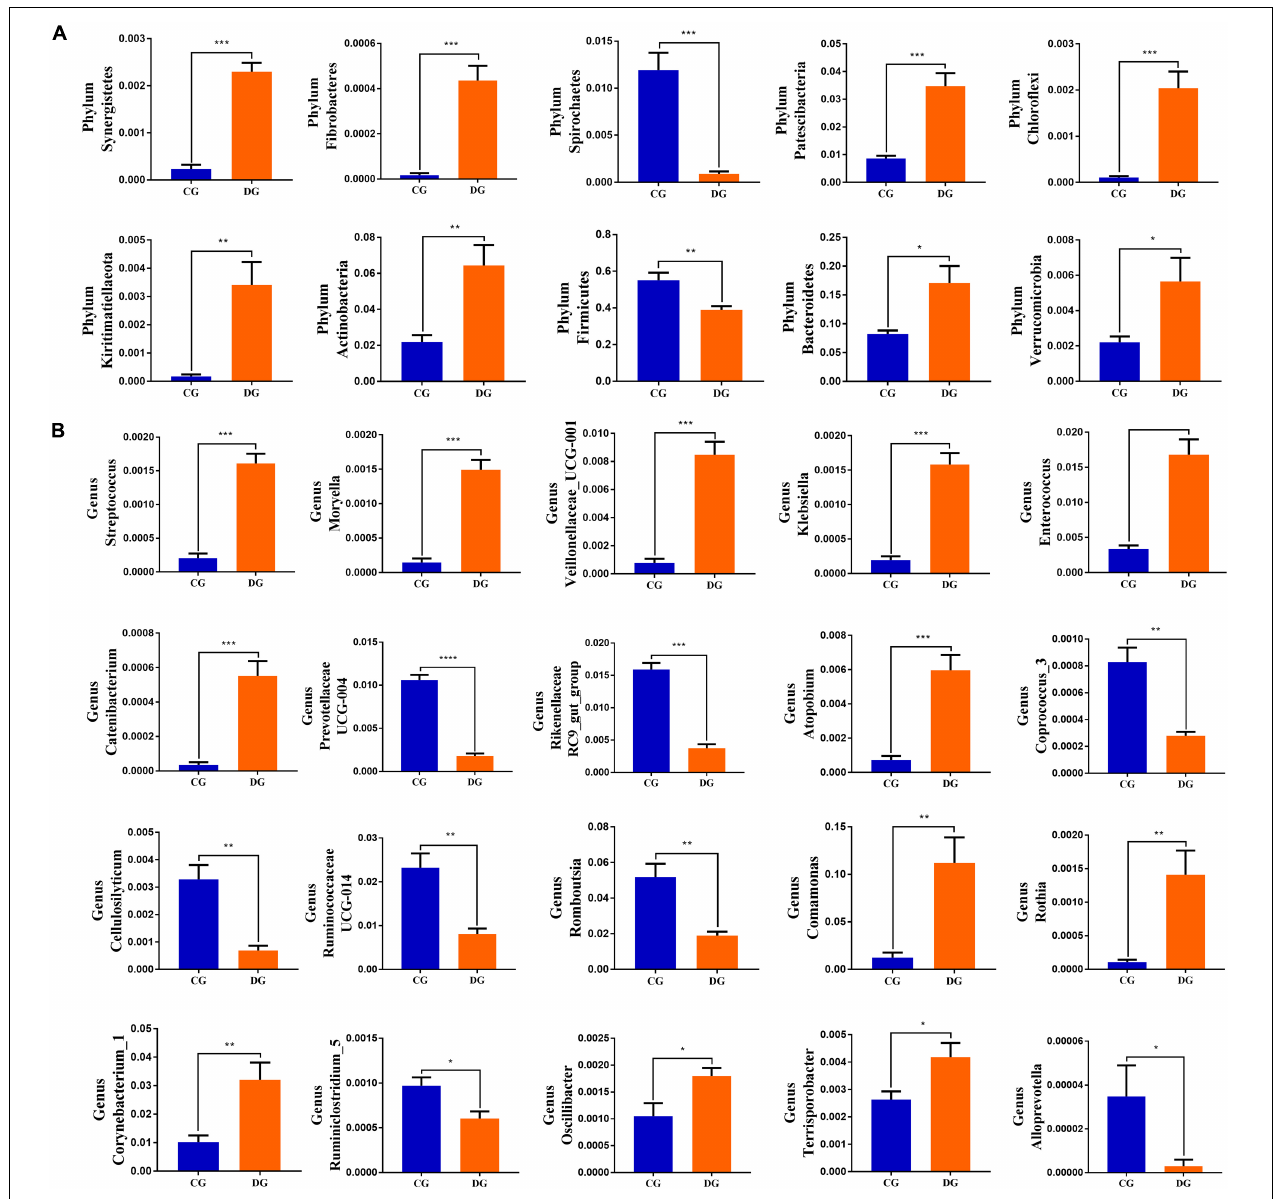
FIGURE 4 | Significant alternations in the gut bacterial abundance at the level of phylum (A) and genus (B) during diarrhea. All of the data represent means ± SD. * p < 0.05; ** p < 0.01; *** p < 0.001 and **** p <